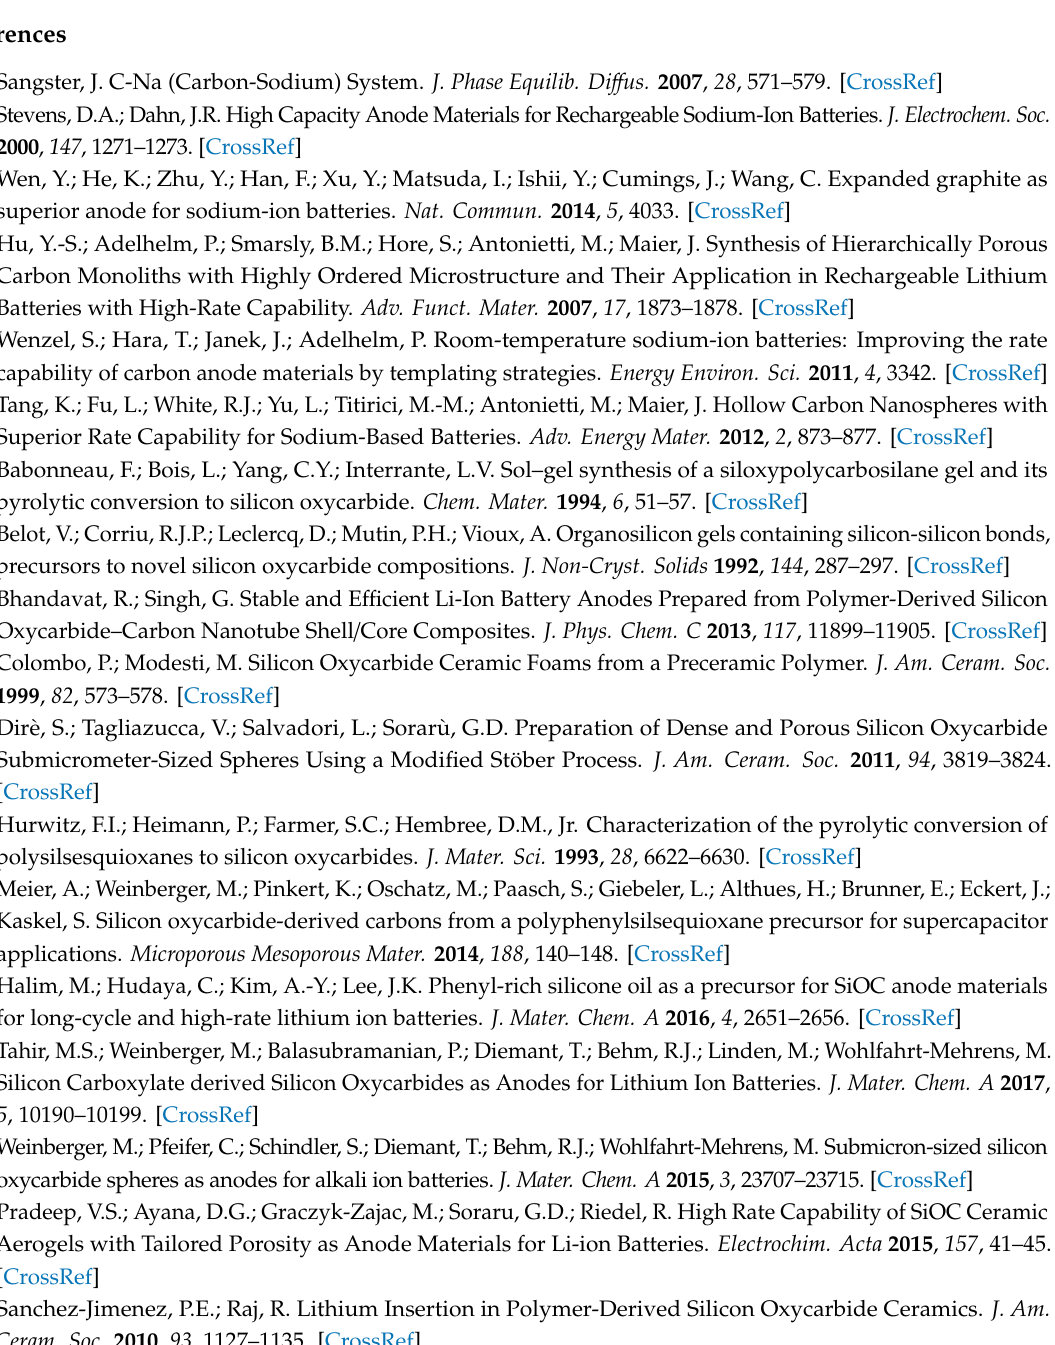
Figure S1: TEM image of sample BPO. Figure S2: Large TEM image of sample